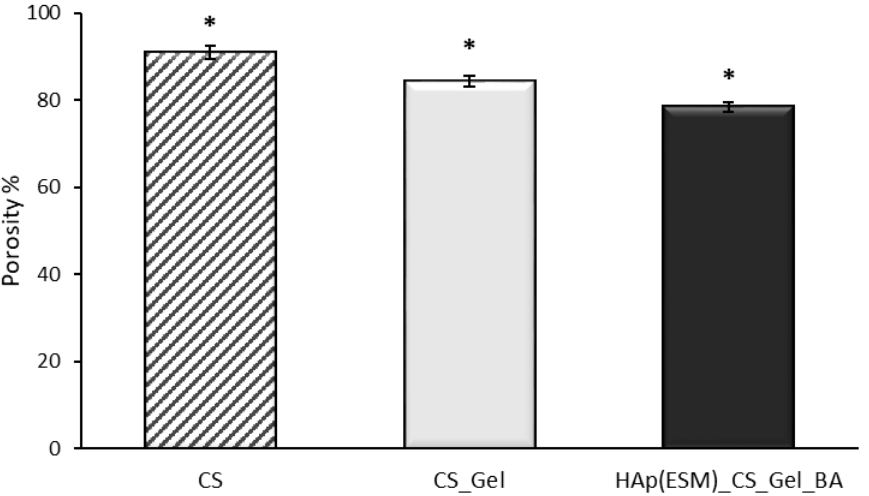
Figure 11. Open porosity % evaluation (presented as mean ± S.D. of 3 replicates); * means a value p < 0.005, obtained by single factor ANOVA test, followed by a post-hoc Bonferroni corrected two tails t -test (n = 3).